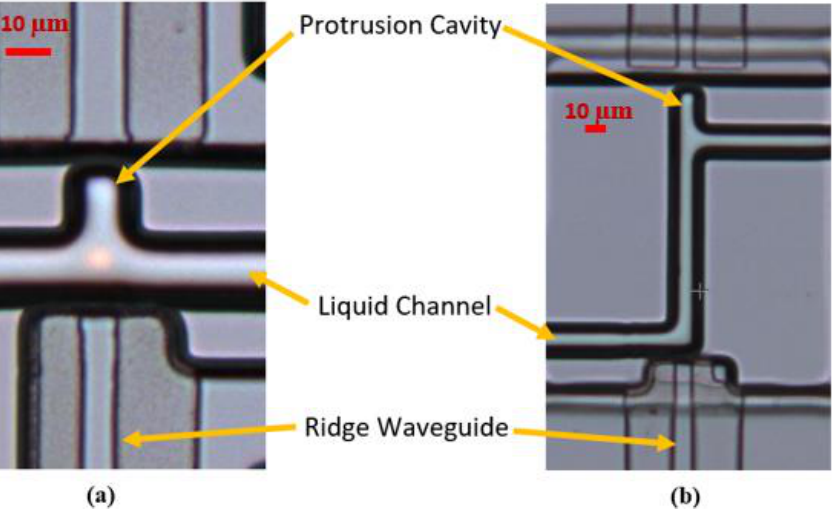
Figure 3. Optical manipulation using the orthogonal force design ( a ) and the gradient force design ( b ). The orthogonal force design introduces radiation pressure perpendicular to the fluid stream and has a short (~10 μ m) optofluidic section. The gradient force design introduces light in parallel to the fluid flow and has an optofluidic focusing section (~100 μ m) before the protrusion cavity. Images taken with an optical microscope.